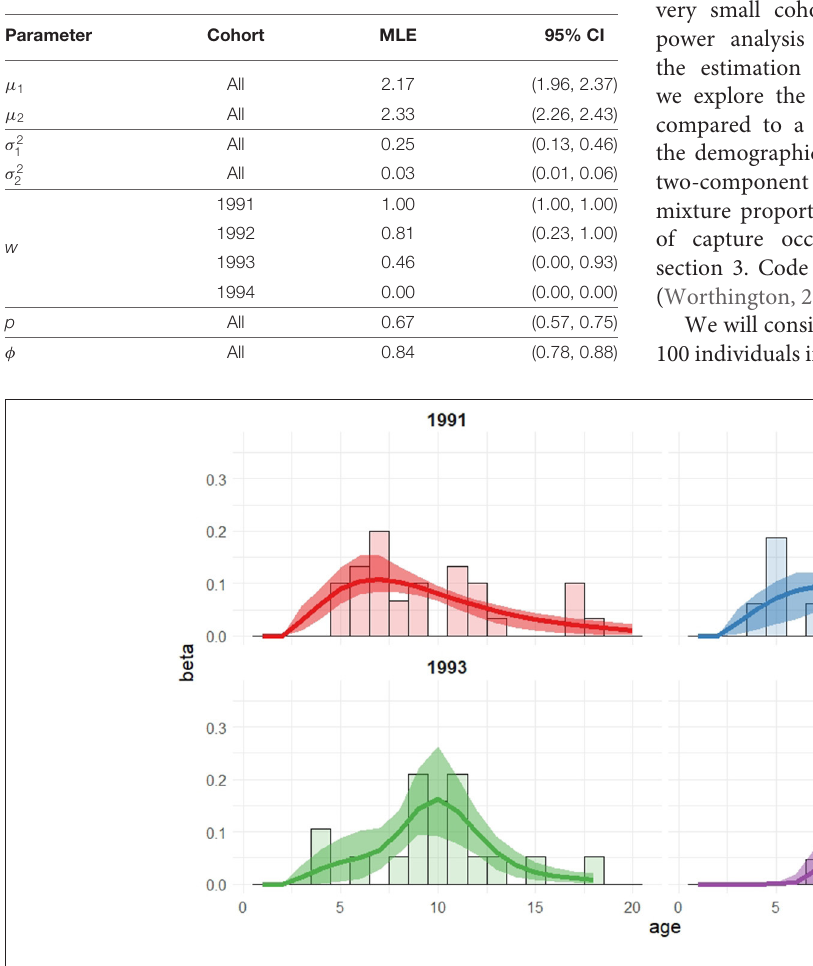
TABLE 2 | Parameter estimates, and 95% bootstrap confidence intervals, for the Isle of May gray seal study model with constant capture and survival probability and cohort dependent mixture proportions (two log-normal mixture).